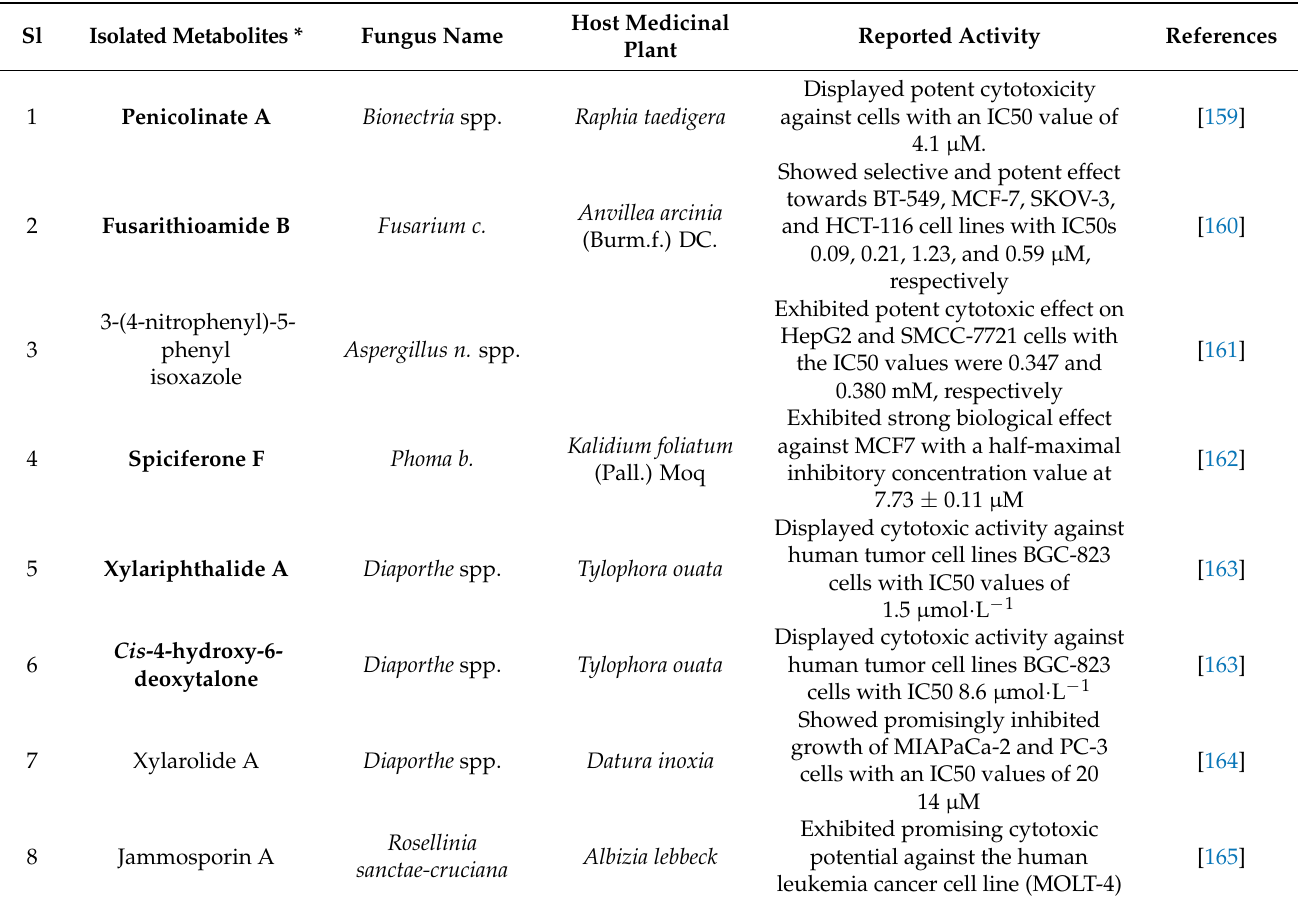
Table 3. Recently (2018–2020) reported potential cytotoxic metabolites isolated from medicinal-plant- associated endophytic